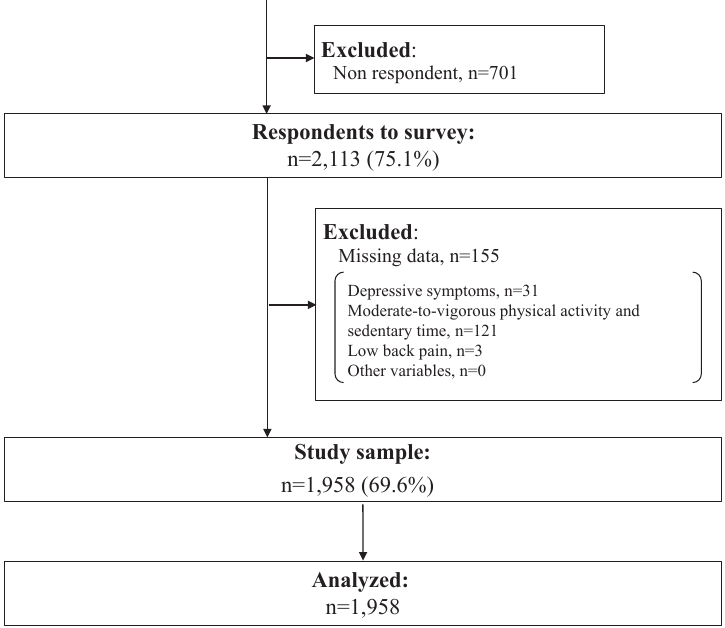
Figure 1. Flowchart of the